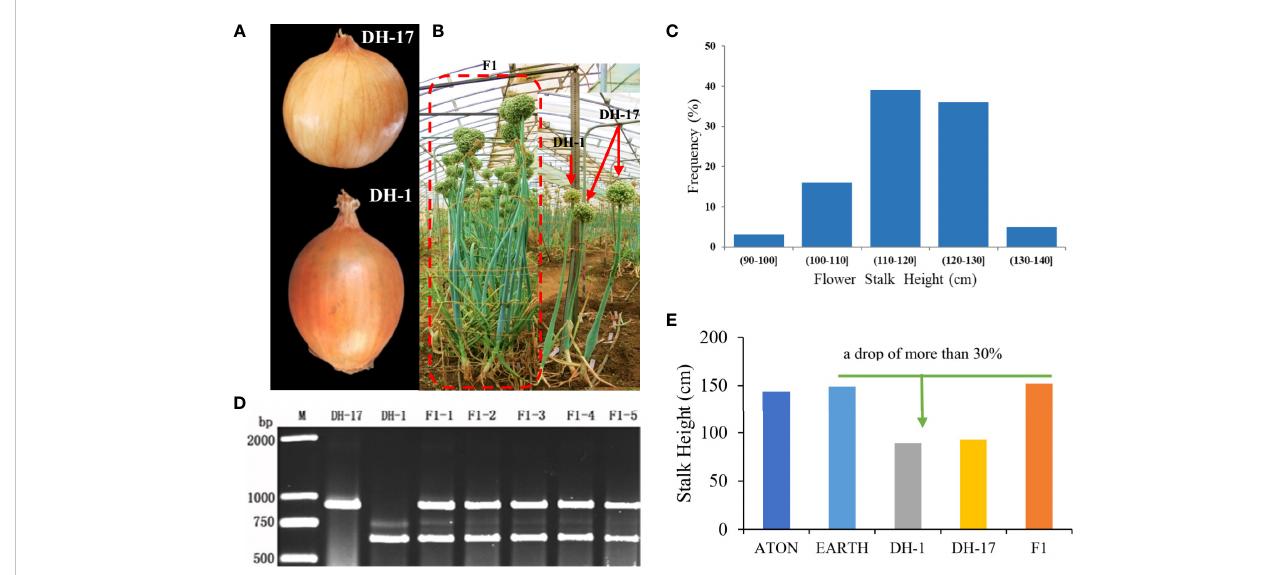
FIGURE 1 Phenotypes of the parental inbred lines and the F 1 , F 2 individuals. (A) Paternal line DH-17 and maternal line DH-1; (B) Plant phenotypes of both parents and F 1 individuals; (C) Phenotypes evaluation of fl ower stalk height for the F 2 individuals; (D) Genotypes of both parents and partial F 1 individuals by the PCR markers DNF-566 and DNS-357; (E) Height of fl ower stalk for the original hybrids, DH lines and F 1